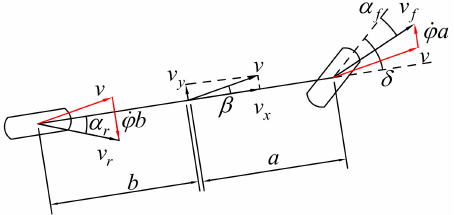
Figure 2. The relationship between the slip angle and center of mass